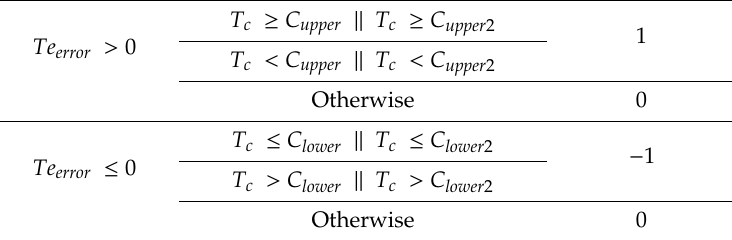
Figure 3. Typical waveforms for the proposed strategy at low speed. Table 2. Rules of interleaving-carrier-based CFTR-DTC